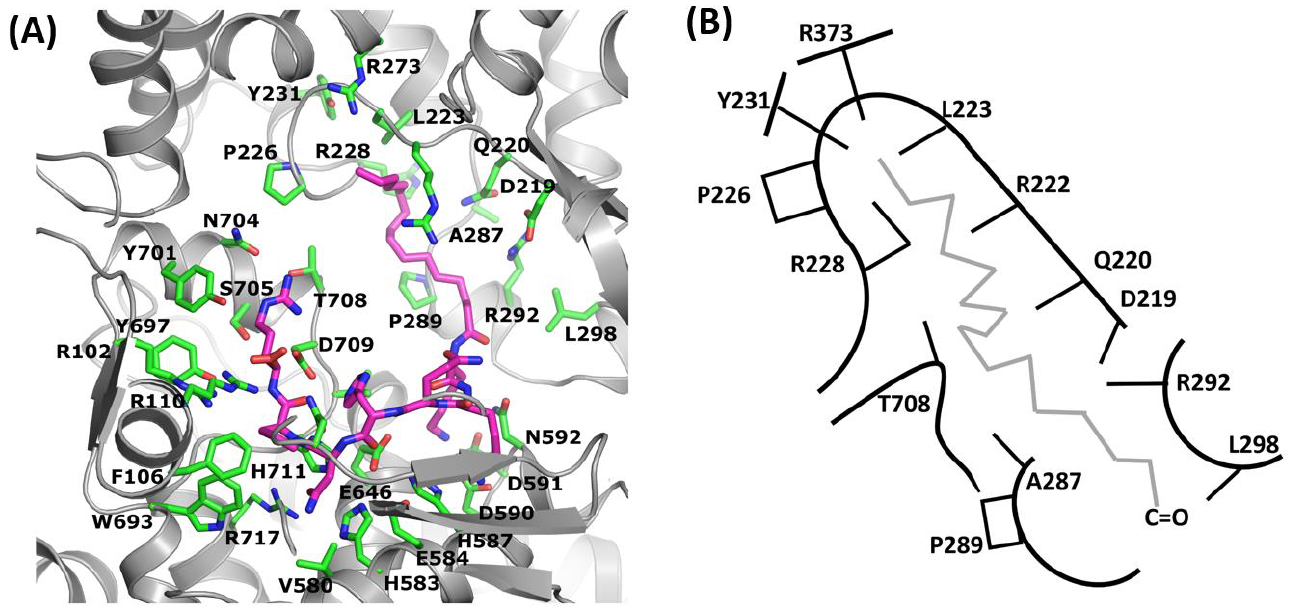
Figure 2. The result of the docking simulation of Stear-KKQHNPR ligand to human NEP structure. ( A ) Protein shape was colored gray. The interacting residues were described with one letter abbreviation and colored green. The ligand was colored purple. ( B ) Schematic representation of the fatty acid aliphatic chain binding pocket. One letter abbreviation was used to point to the interacting residues. The location (direction) of the sidechains constituting the binding pocket was shown as sticks.